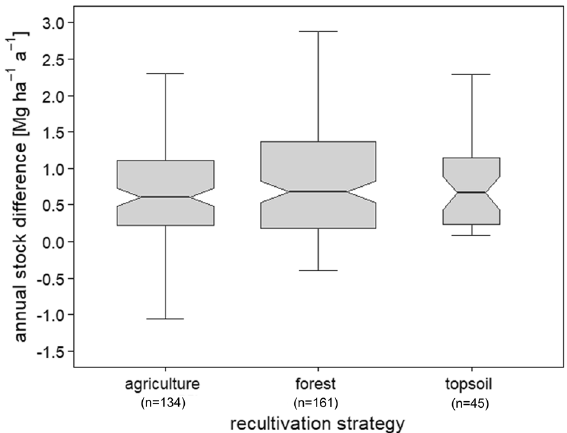
Figure 2. Annual amount of SOC sequestered by mine soils [Mg ha −1 a −1 ] that were recultivated employing the three main recultivation strategies (i) agriculture (incl. agriculture, agriculture with fertiliser, agriculture with topsoil, agriculture with topsoil and fertiliser, and agriculture with liming, topsoil, and fertiliser), (ii) forest (incl. forest, forest with topsoil, forest with liming, and forest with fertiliser), and (iii) topsoil (incl. topsoil by itself and topsoil with fertiliser). Agroforestry was omitted from this figure, as it was decidedly underrepresented with one single study containing 15 values. Each box contains the middle 50% of the data of a category. The mean of the data is shown as a horizontal solid line within the box. The whiskers indicate the lower and upper quartile of the data and are limited to 1.5 times the interquartile range. Outliers were removed from the boxplots in this figure to better visualise the differences between strategies. Notches represent the 95% confidence interval of the mean. The number of observations listed in the plot excludes outliers. The number of outliers that were removed is 21 for agriculture, 28 for forest, and 2 for topsoil. The original plot including all outliers can be found in the supplementary material.